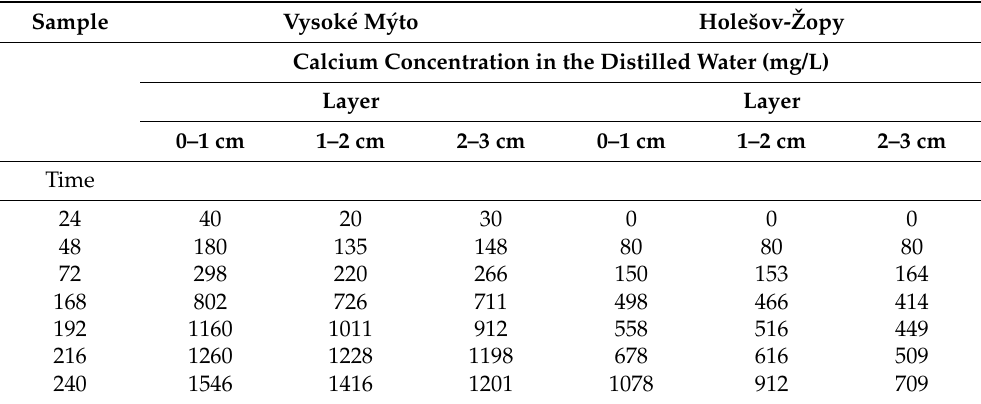
Table 2. Diffusion experiment with the Vysok é M ý to and Holešov-Žopy bricks. The results are expressed as a cumulation of calcium in distilled water over the time